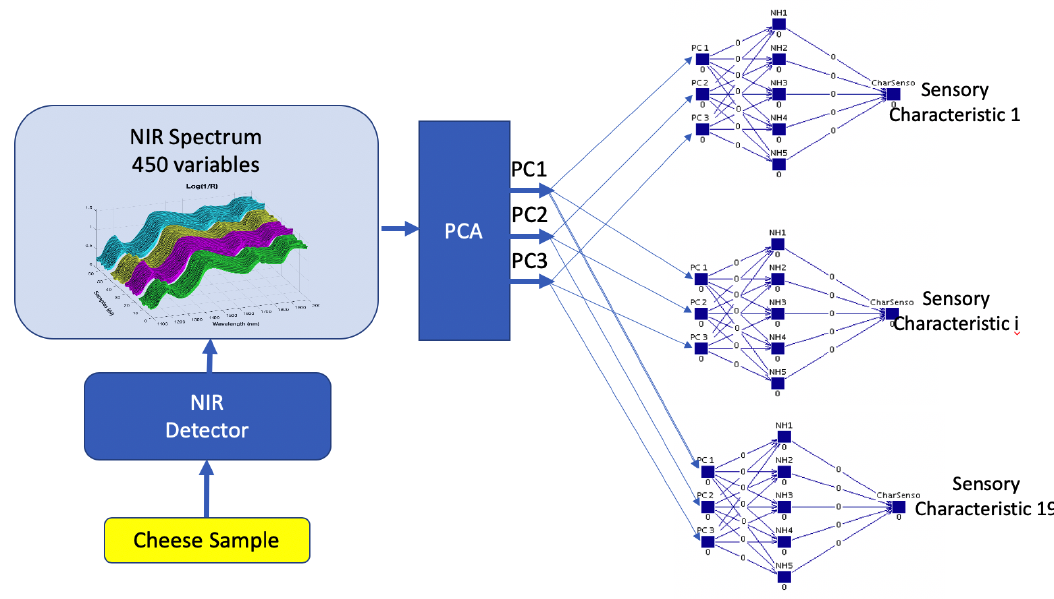
Figure 1. Global scheme of the prediction of 19 sensory parameters for each cheese sample. PC1, PC2 and PC3 denote the three principal components of Principal Components Analysis (PCA) on NIR spectra. Sensory characteristic i refers to each of the 19 sensory parameters of the cheese to be